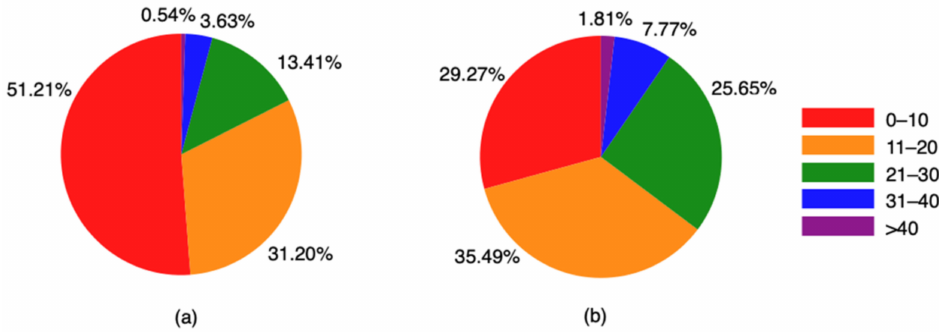
Figure 1. UPI (University Personality Inventory) scores by type. ( a ) NLBEs; ( b ) LBEs. Percentages of participants who responded “yes” to the UPI’s four key items were shown in Figure 2. The individuals with left-behind experience had a significantly higher percentage in each item, especially in Item 8. More than 25% of LBEs deemed that their past and family are unfortunate. The percentage of students who often suffered from insomnia or had suicidal ideation in LBEs, was higher than that in NLBEs, and the former was approximately twice that of the latter. Therefore, it can be preliminarily concluded that the left-behind experience may correlate with poor mental health